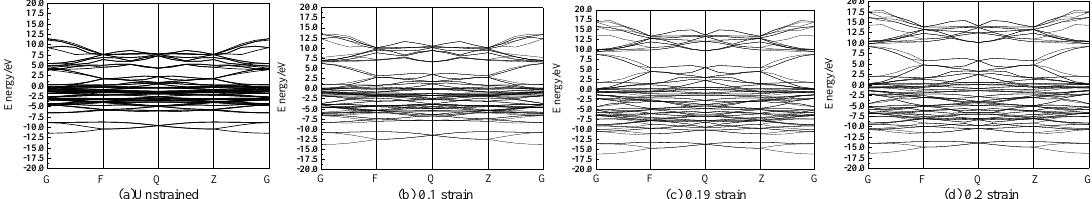
Figure 8. The change in band structure in the process of DO3 placed under triaxial compressive strain. ( a ) unstrained, ( b ) 0.1 strain, ( c ) 0.19 strain and ( d ) 0.2 strain.